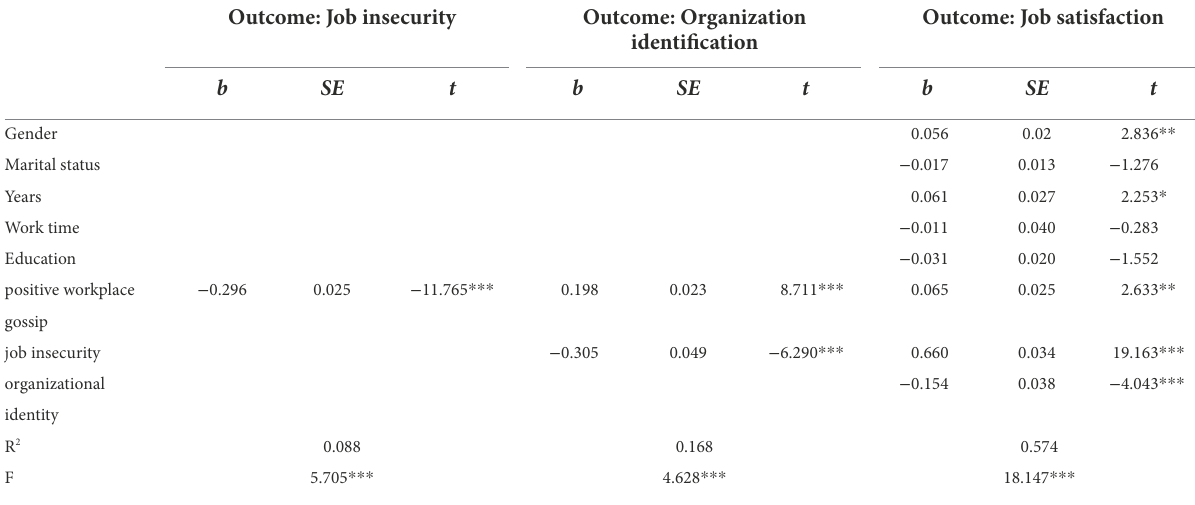
TABLE 3 The mediating role of job insecurity and organizational identity.